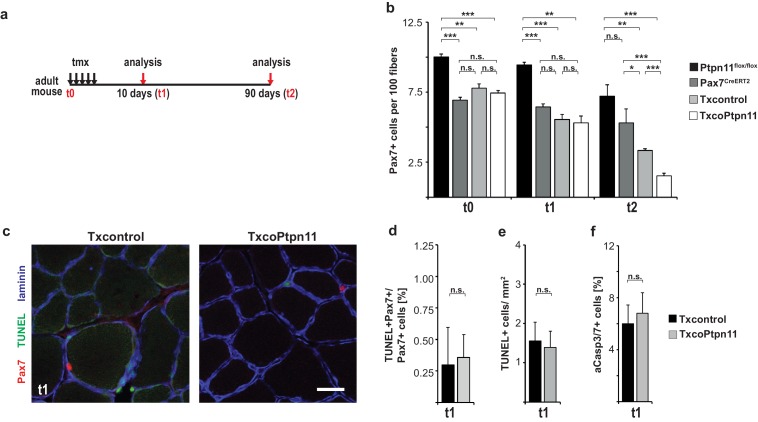
Ptpn11 is essential for long-term maintenance of satellite cells and muscle regeneration.(a) Outline of the experiment. (b) Quantification of Pax7+VCAM1+ satellite cells/100 fibers in tibialis anterior muscle before (t0), 10 (t1), and 90 (t2) days after tamoxifen administration. (c) Immunostaining for Pax7 (red), TUNEL (green) and laminin (blue) of sedentary muscle 10 days after tamoxifen administration. (d) Quantification of the proportions of Pax7+ cells that are TUNEL+. (e) Quantification of TUNEL+ cells/mm2. (f) Flow cytometric quantification of VCAM1+CD31-CD45-Sca1- satellite cells possessing active caspase 3 and 7 in Txcontrol and TxcoPtpn11 mice two weeks after tamoxifen administration. n.s. = not significant, *p<0.05, **p<0.01, ***p<0.001. Error bars show S.E.M. Scale bar: 25 µm.